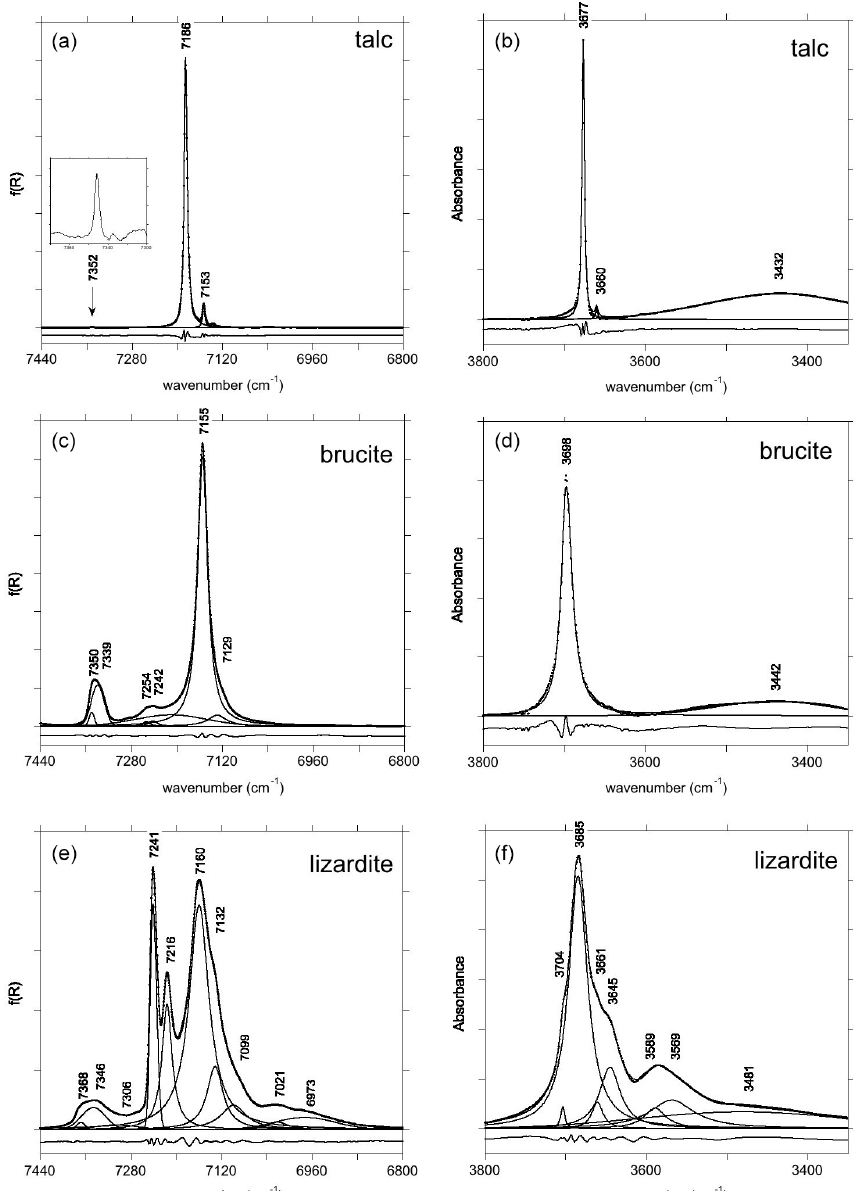
Figure 1. Fundamental (right) and first overtone (left) OH stretching spectra of talc (a, b) , brucite (c, d) and lizardite (e, f) . The spectra have been decomposed into individual components, and residues are reported at the bottom with an arbitrary shift for clarity sake.